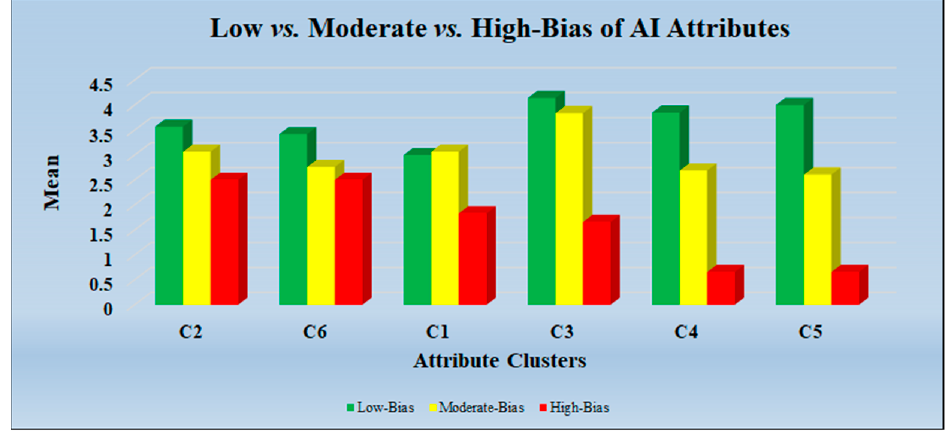
Figure 13. Low vs. Moderate vs. High-Bias of AI Attributes (C1: Citation, C2: Objective and Design Methodology, C3: AI Architecture, C4: Optimization of AI Model, C5: Performance Evaluation of AI Models, C6: Clinical Evaluation and Benchmarking).